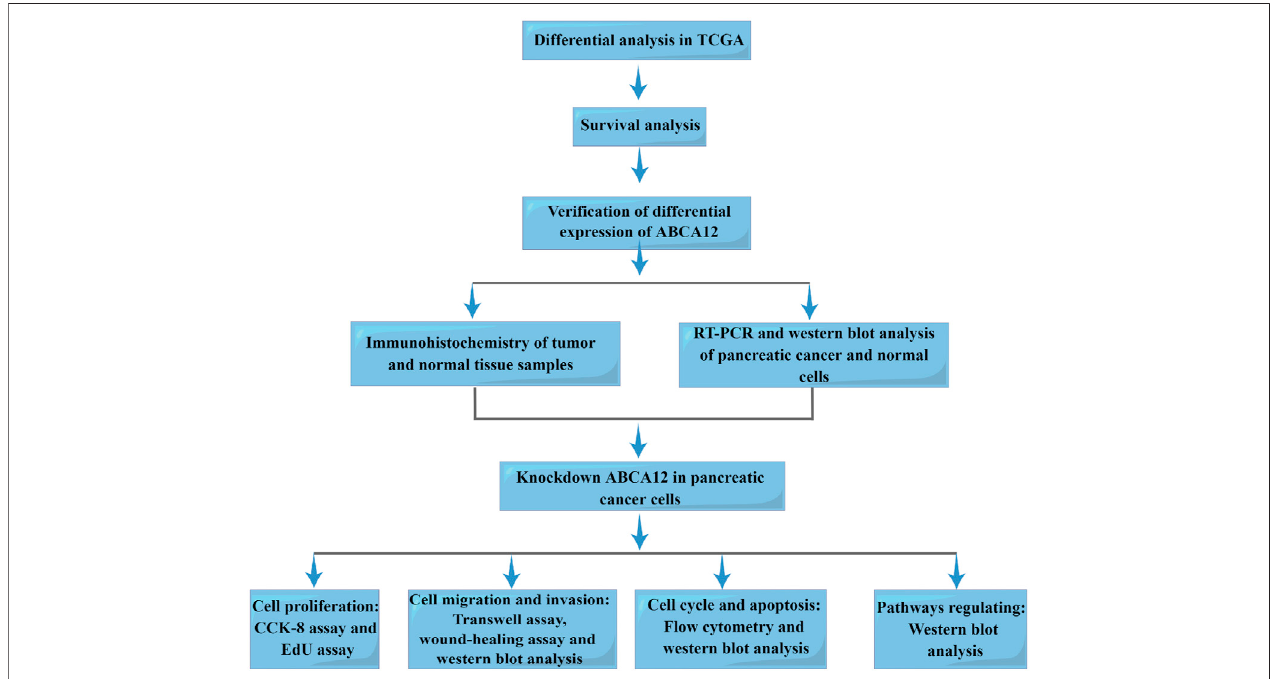
FIGURE 1 | Work fl ow of this